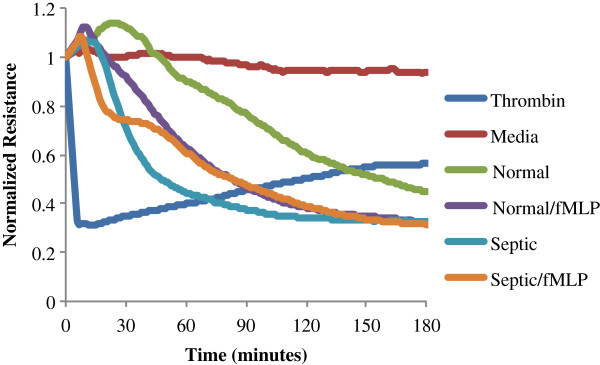
Representative electric cell-substrate impedance sensing tracing. Change in normalized monolayer resistance with respect to time. t = 0 represents the time of addition of thrombin, media, untreated neutrophils from a healthy volunteer (normal), N-formyl-l-methionyl-l-leucyl-l-phenylalanine (fMLP)-treated neutrophils from the same healthy volunteer (normal/fMLP), untreated neutrophils from a septic patient (septic), or fMLP-treated neutrophils from the same septic patient (septic/fMLP). fMLP treatment was undertaken using 10–6 M fMLP. All neutrophil populations were found to cause a progressive loss of barrier function.